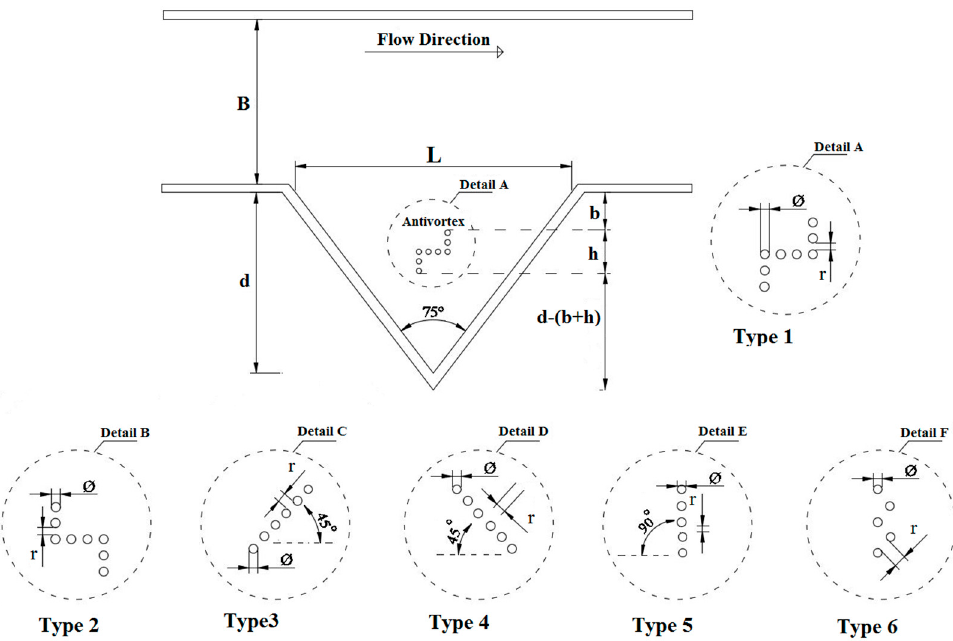
Figure 2. Geometric characteristics and location of permeable and impermeable antivortexes.